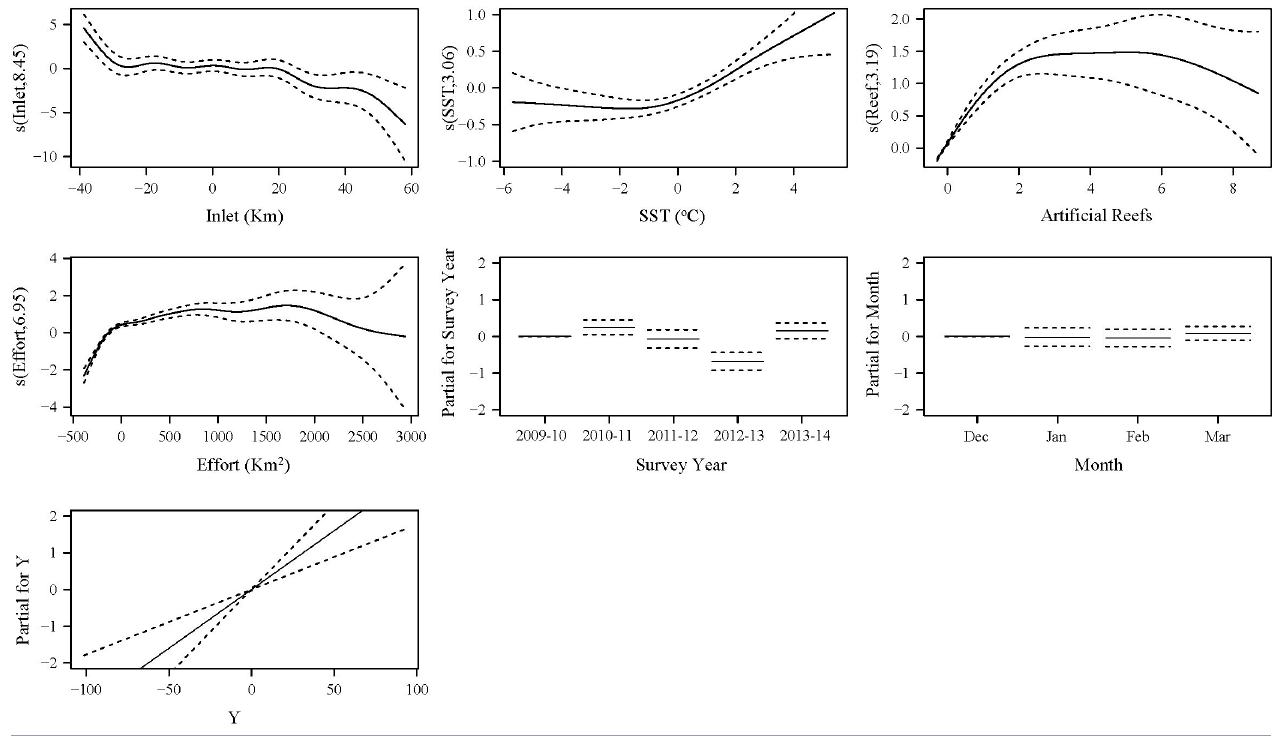
Fig. 2. Smoothed curves of the additive effects of covariates from the best-fit model explaining the relative abundance of offshore recreational vessels in the SEUS. Predictor variables include northing (y), distance of grid centroids to the nearest inlet (Inlet), sea surface temperature (SST), Chlorophyll a (Chlo a), abundance of artificial reefs (Reef), aerial surveys effort (Effort), survey year, and survey month (Month). Solid lines depict estimates of the smooth function and dotted lines indicate 95% confidence